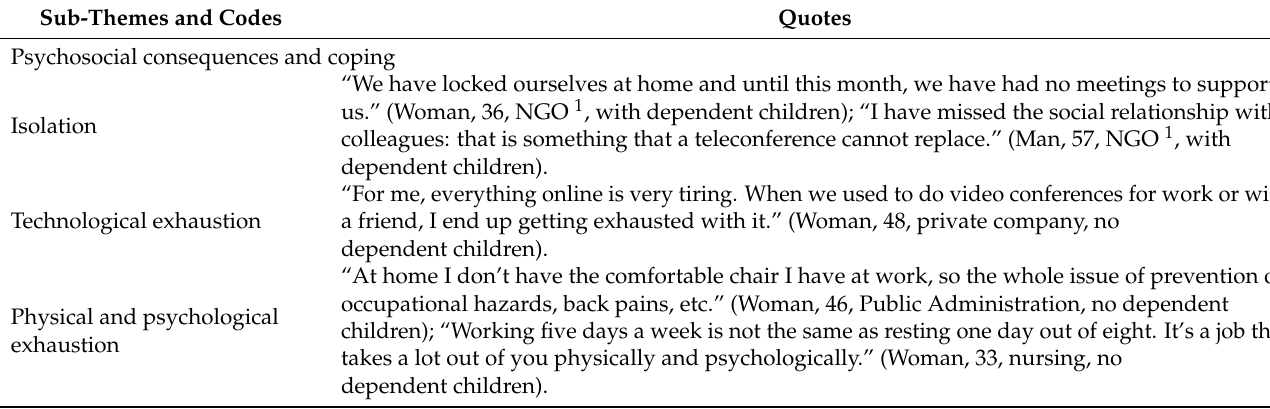
Table 4. Theme 4 developed from thematic analysis in Study 1: “psychosocial consequences and coping with the situation”. Sub-Themes and